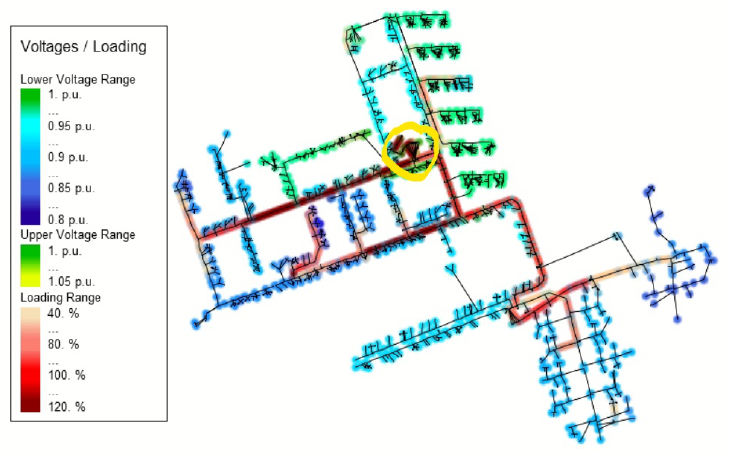
Figure 10. Grid loading heatmap of SUB1 grid with PSM with EV 80% penetration in winter, highest line loading moment.